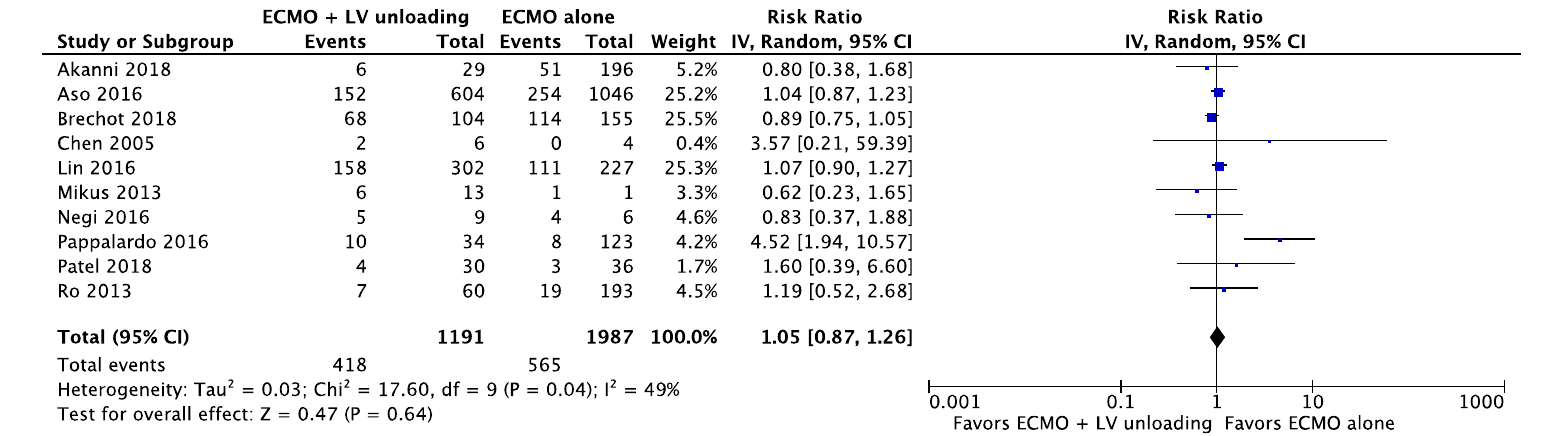
Figure A9. Acute kidney injury (AKI).